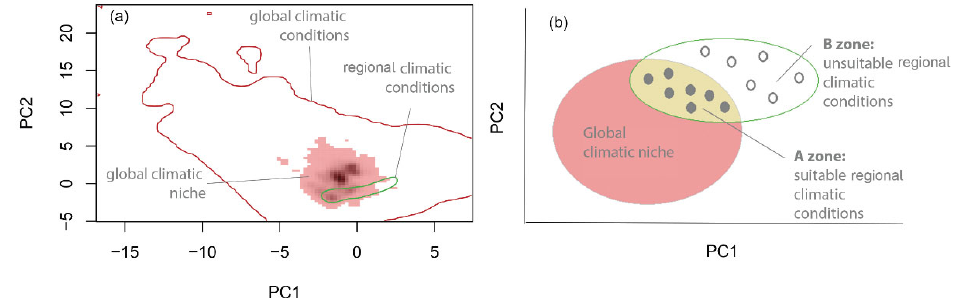
Figure 5. Diagrammatic representation of the environmental grid [53] to identify suitable and unsuitable habitats. ( a ) PCA with global climatic niches, intersected with the regional scale (study area in central Chile) climate niche for Tragopogon porrifolius as an example. ( b ) Identification of suitable (black points) and unsuitable conditions (white points) for the species in the study area in Chile.